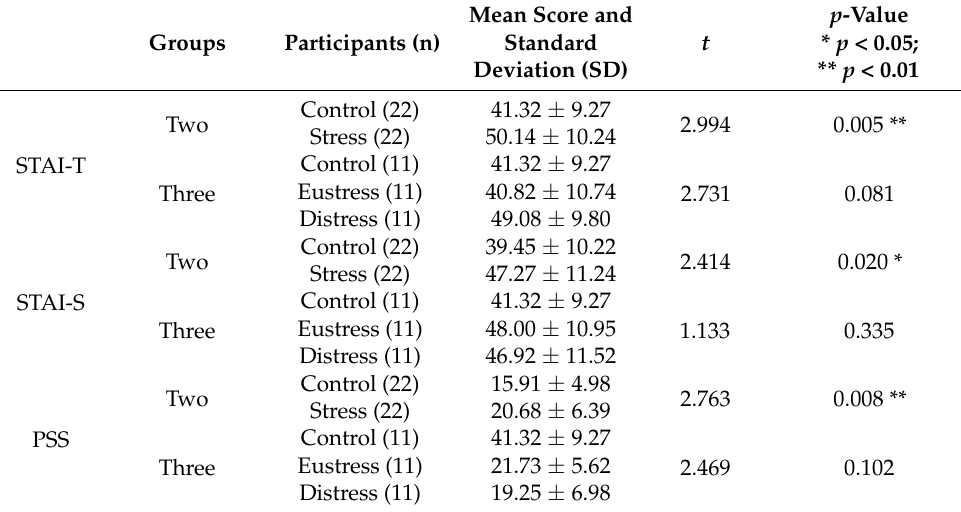
Table 4. Comparison of anxiety and stress scales for each group with different sAA levels: